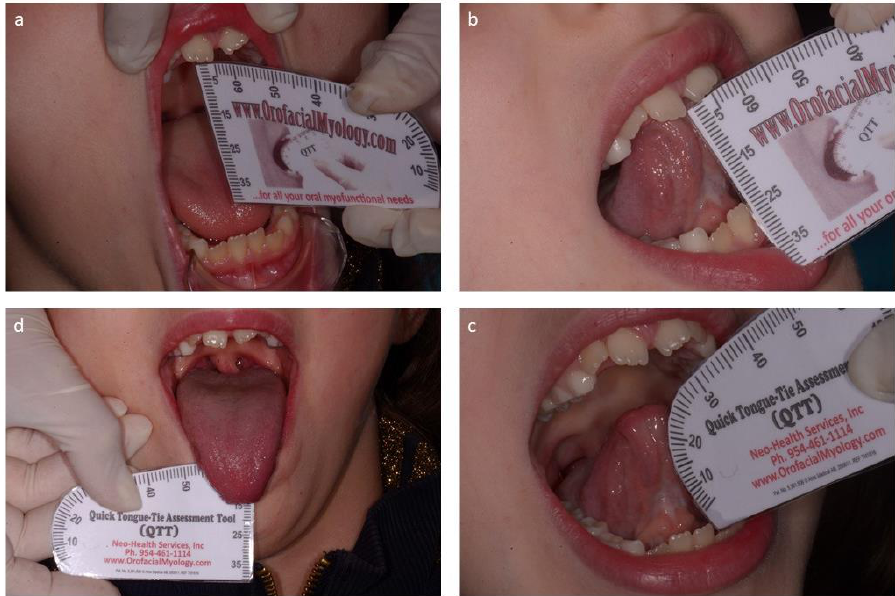
Figure 3. Quantitative evaluation t4: ( a ) (MAB), ( b ) (MIO), ( c ) (MOTTIP), ( d ) (PROTRUSIONE).